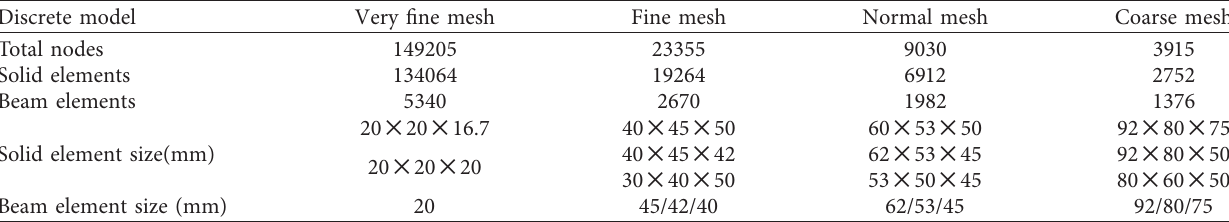
Table 3: Mesh data for the discrete